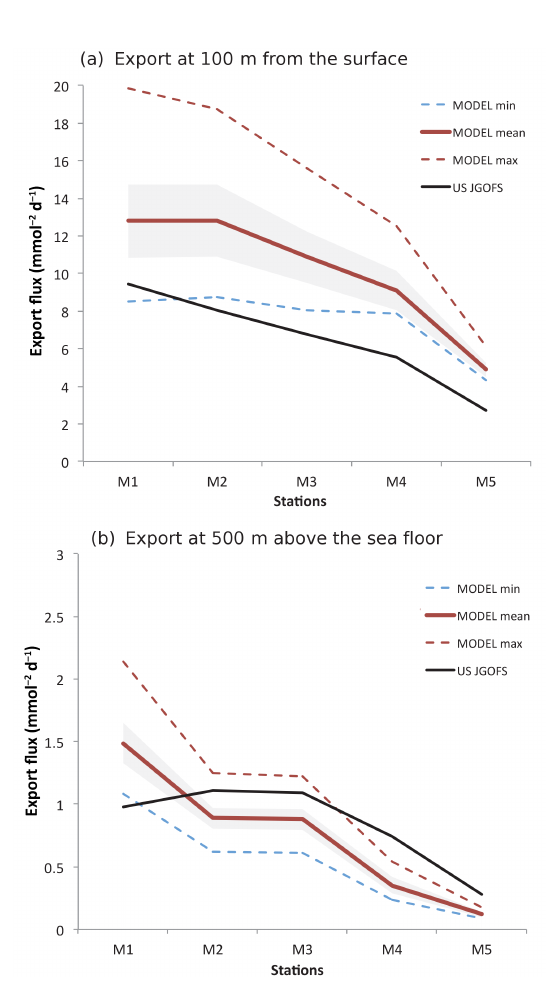
Figure A6. Export fluxes at mooring stations M1 to M5. Annual- mean export flux at the M1–M5 stations as estimated from in situ observations (black) and simulated in the model (red) at 100 (a) and 500m (b) above the seafloor. The dashed lines refer to mod- eled maximum (red) and minimum (blue) annual export fluxes. The shading indicates the ± 1 standard deviation from the model